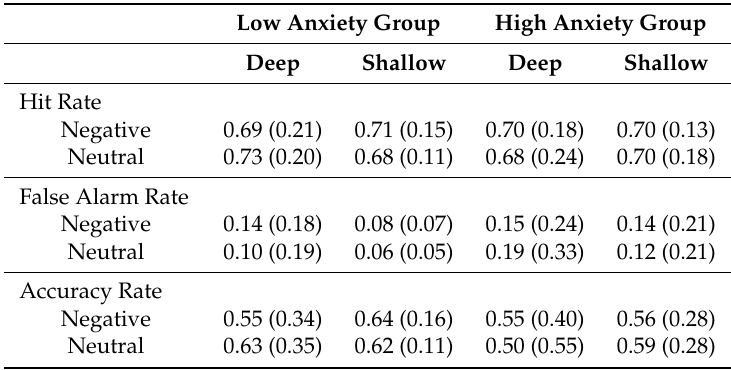
Table 1. Test 1: Memory Performance for Participants with High versus Low Trait Anxiety in the Deep and Shallow Encoding